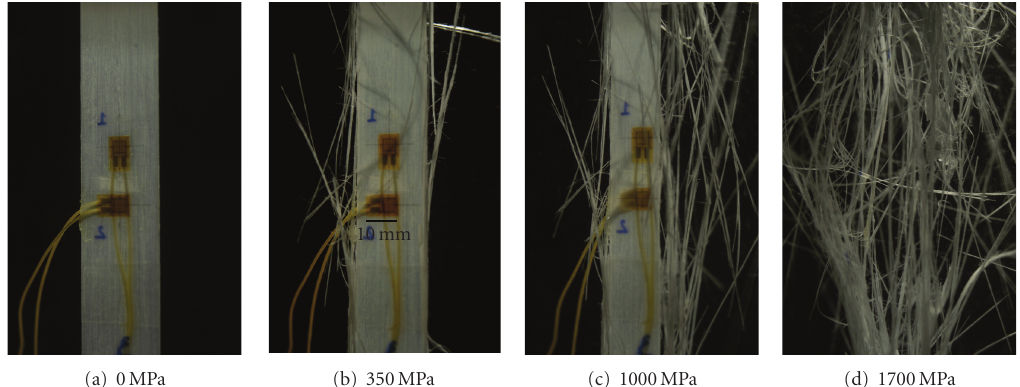
Figure 8: Failure by progressive edge delamination in blank samples (a); initiation of the failure (b-c) and slow propagation; final failure (d).